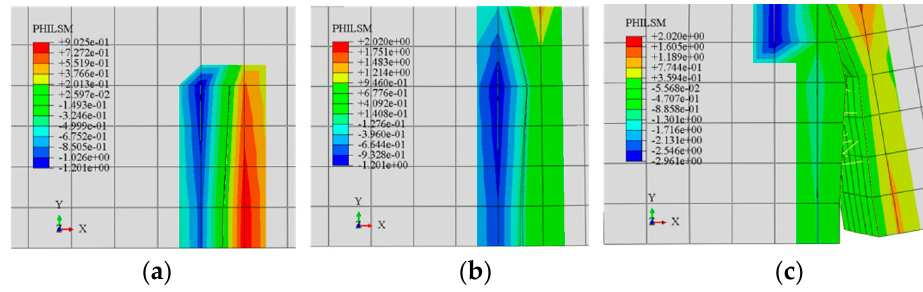
Figure 5. Crack propagation in beams at different loads. ( a ) 50 N; ( b ) 90 N; ( c ) 115 N.